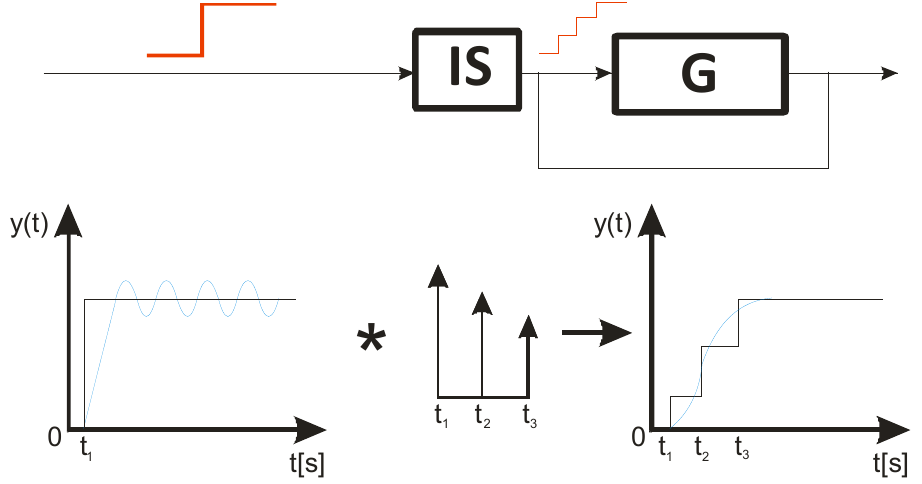
Figure 4. Implementation of a input filter by a convolution operation, where the black waveform represents the input and the blue signal represents the system response.